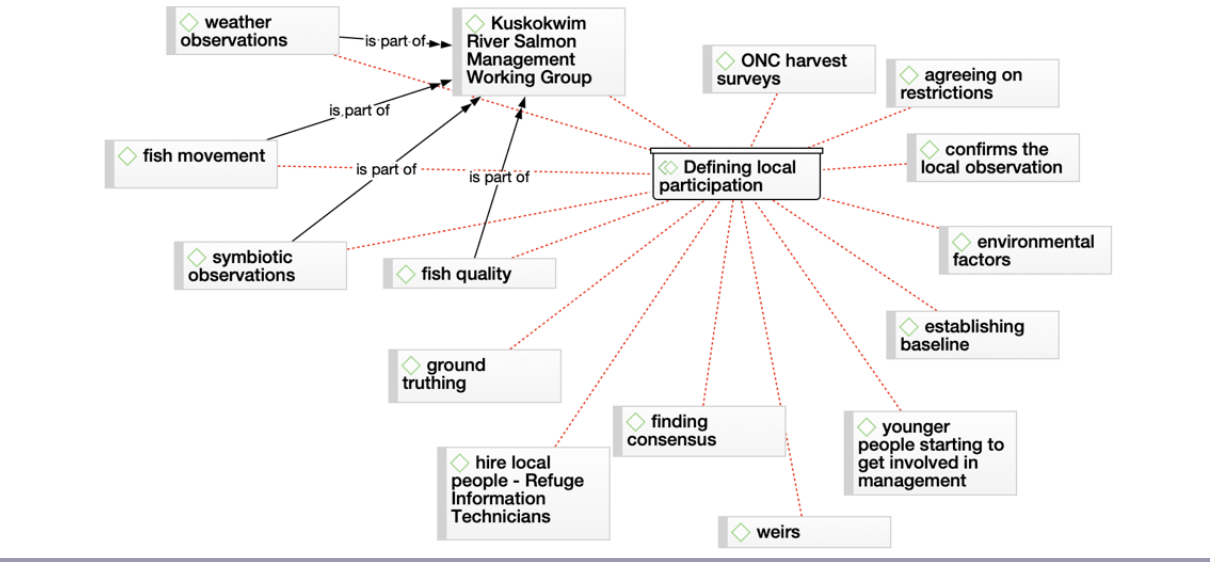
Fig. 2 . Visual representation of the themes related to defining local participation in data production. This networked diagram was generated from our codes in Atlas.ti. ONC, Orutsararmuit Traditional Native